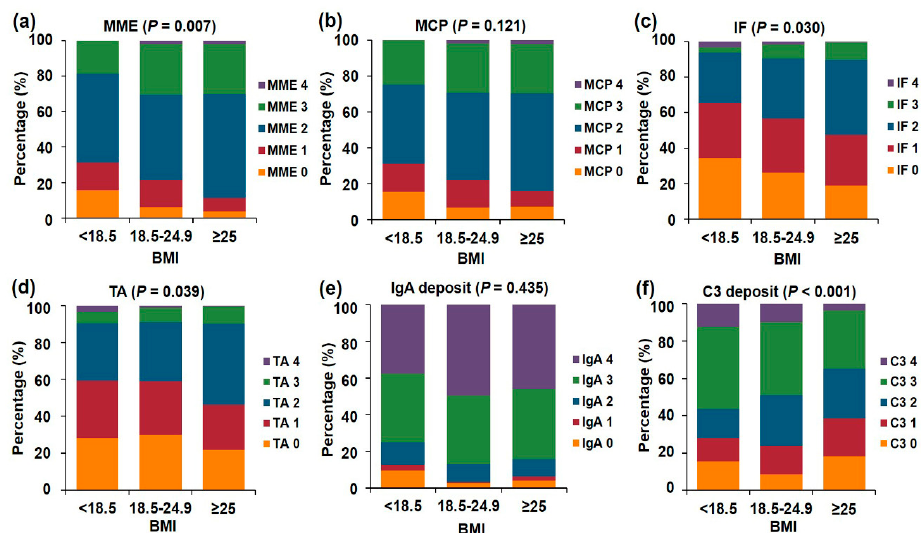
Figure 1. The distribution of histopathologic scores according to the three BMI groups. ( a ) Mesangial matrix expansion (MME). ( b ) Mesangial cell proliferation (MCP). ( c ) Interstitial fibrosis (IF). ( d ) Tubular atrophy (TA). ( e ) IgA mesangial deposition. ( f ) C3 mesangial deposition. Table 3. The distribution of histological classifications according to the three BMI groups.